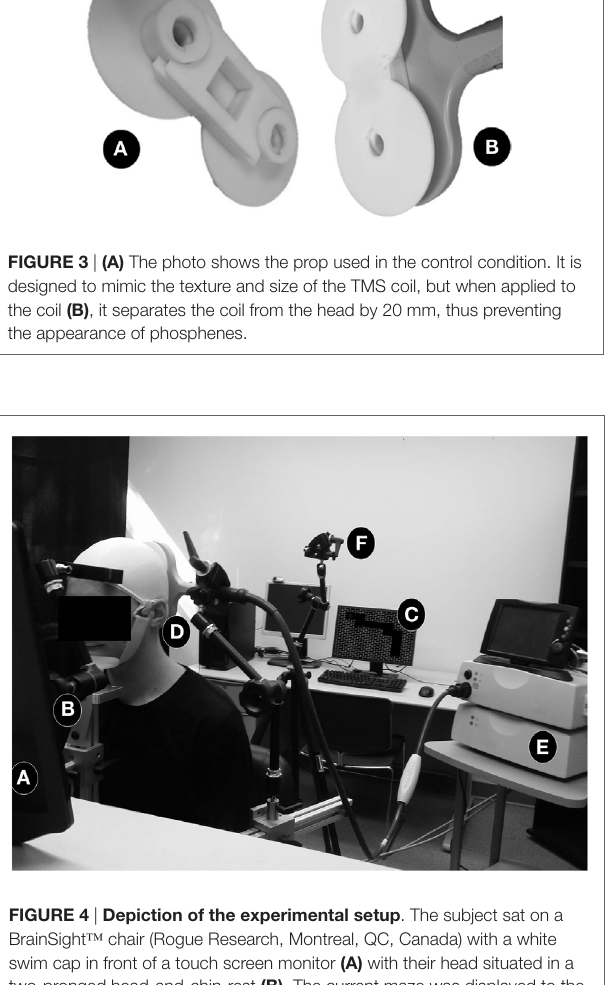
FigUre 5 | The phosphene threshold for each subject was found by first marking a 4 cm × 4 cm grid 1 cm dorsal to the inion . A candidate location was determined by stimulating at increasing intensities up to 75%. If a phosphene was not perceived, a new location was examined. The final above-threshold intensity was established as the minimum intensity for which subjects perceived a phosphene for 10 consecutive stimulations. Conversely, the subthreshold intensity was established as the maximum intensity for which a subject did not perceive a phosphene after 10 consecutive stimulations.